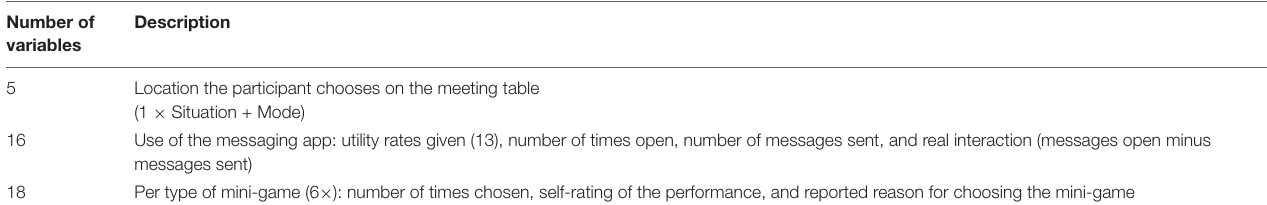
TABLE 2 | Description of the variables obtained from the decisions made during the VR experience, including the related psychological trait of each